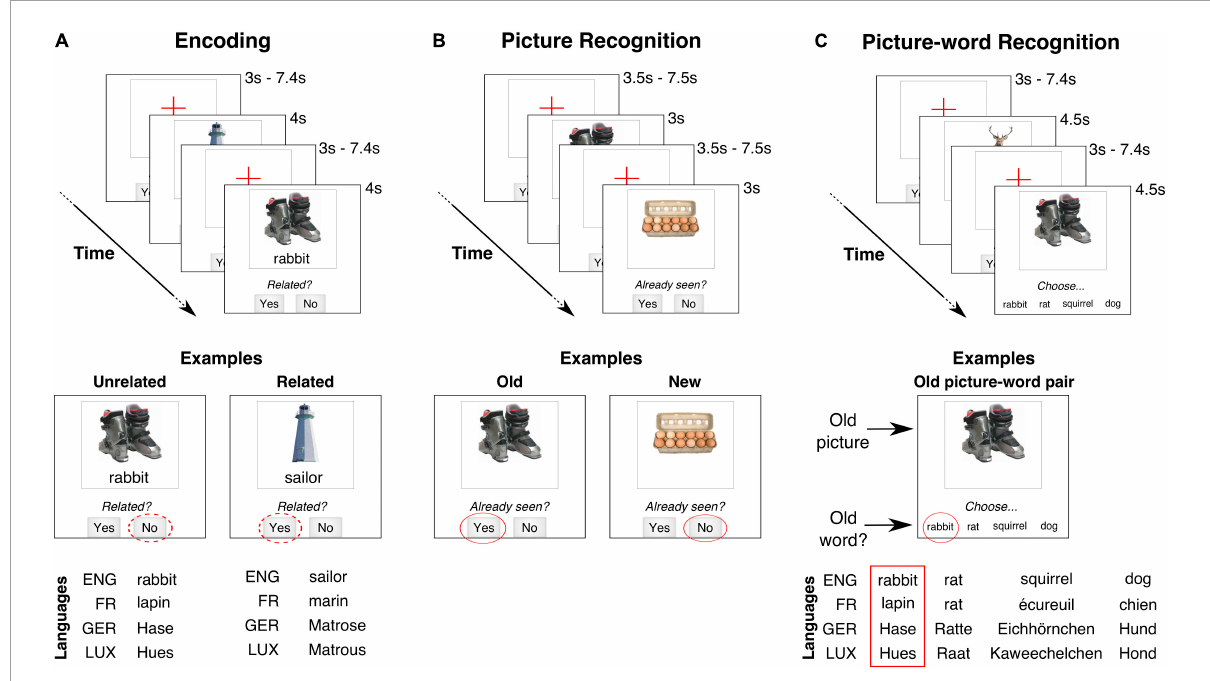
FIGURE1 Schematic of paradigm. Trial timing and stimulus layout (not to scale) for the three task stages, with English as stimulus language. (A) Encoding: A picture-word pair was presented on each trial. Participants categorized as the pair as being related or not. In the examples, the ski-boots and “rabbit” could be categorized as Unrelated (“No” response) while lighthouse and “sailor” might be Related (“Yes” response). These semantic categorizations are assumed to be similar irrespective of stimulus language (ENG, English; FR, French; GER, German; LUX, Luxembourgish). (B) Picture recognition: A picture was presented on each trial. Participants judged whether that picture had been already seen during the encoding task [panel (A) ]. In the examples, the picture of the ski-boots was previously presented (“Yes” response) but that of the egg carton was not (“No” response). (C) Picture-word recognition: The stimulus on each trial was a picture and four words. Participants had to choose the word that had been paired with the picture during the encoding task [panel (A) ]. The three other new words were always semantically related to the target word. All the presented words were matched across stimulus